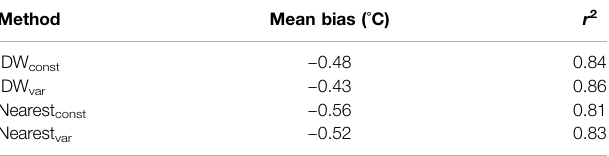
TABLE 2 | Air temperature distribution methods mean bias and r 2